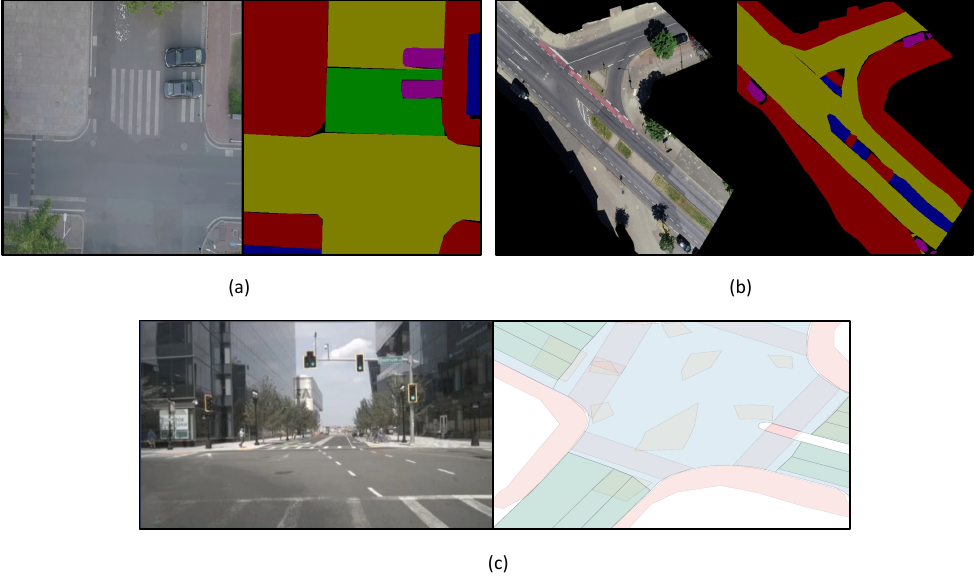
Figure 3. Sample images of an urban traffic shared space with its corresponding semantic label map from ( a ) DUT dataset [29], ( b ) inD dataset [30] and ( c ) nuScenes dataset